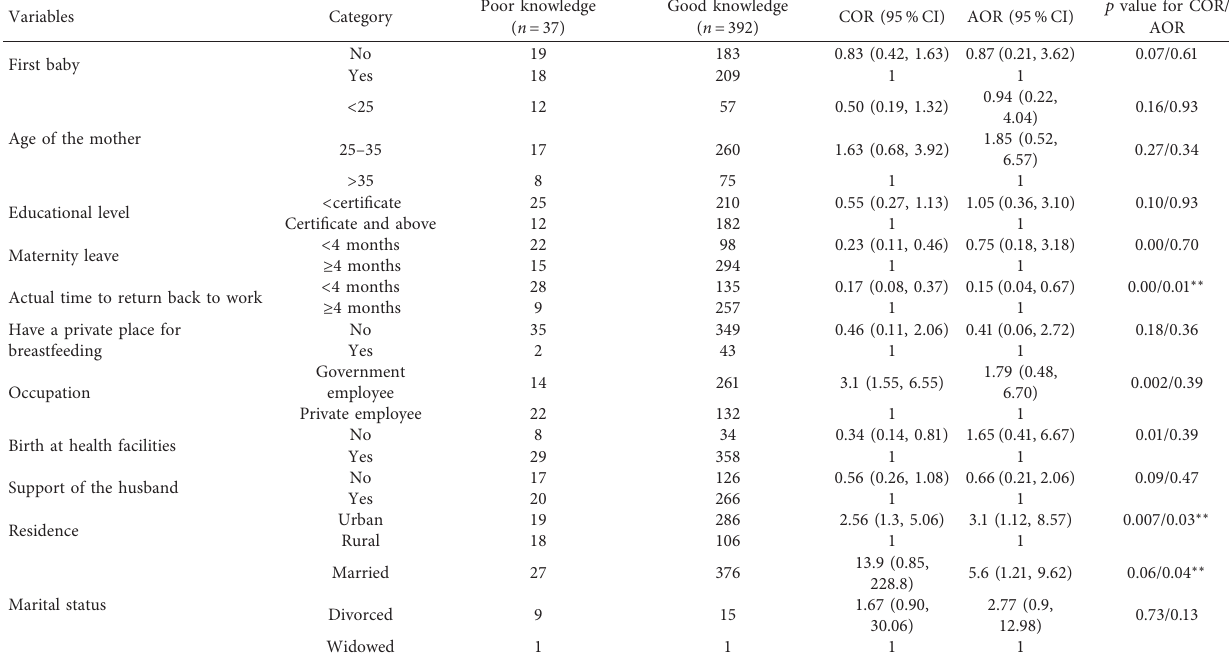
Table 5: The univariate and multivariate logistic regression analysis for knowledge of employed mothers in Mecha district, Northwest Ethiopia, 2019 ( n �